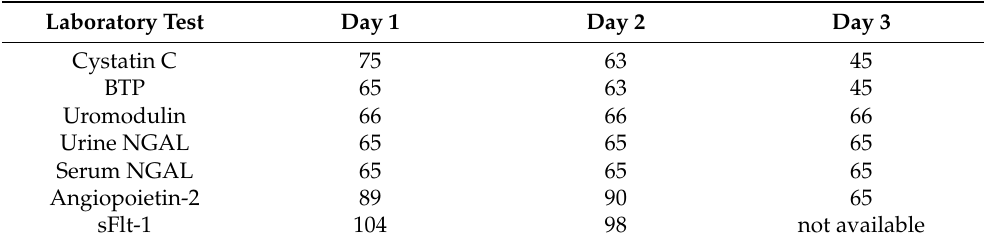
Table A1. Number (percentage) of patients with available results of non-standard laboratory tests in the studied group of 147 patients with acute pancreatitis.